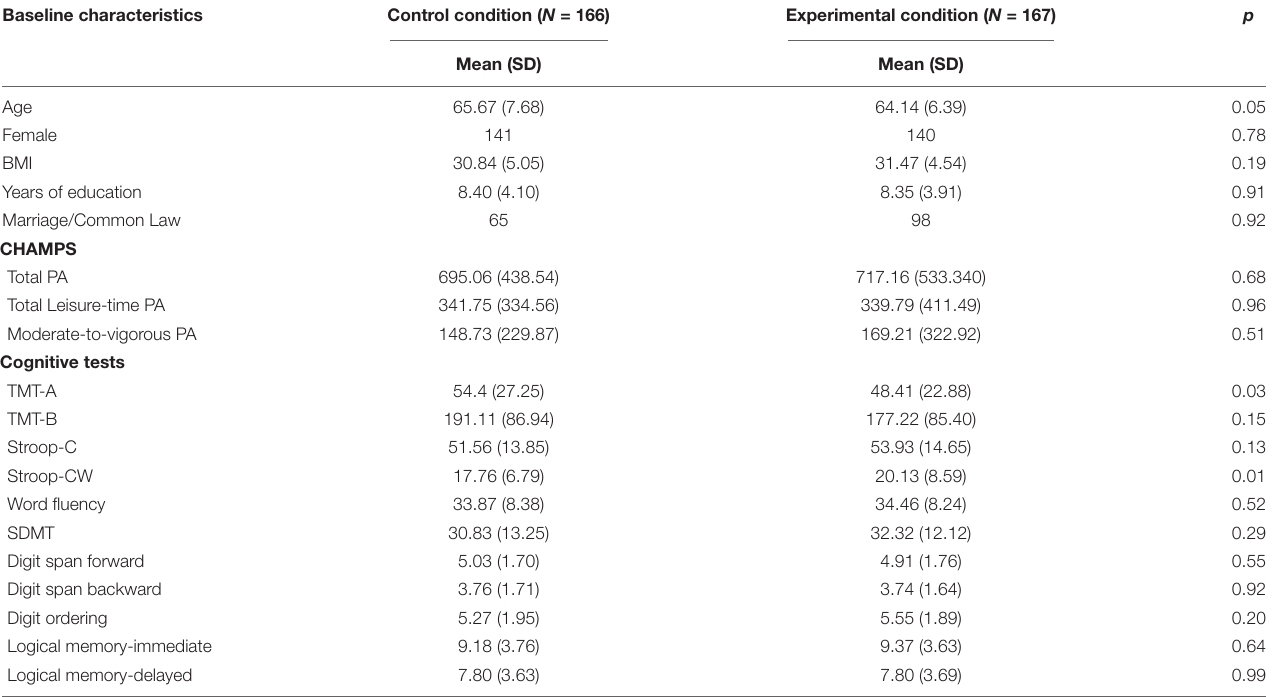
TABLE 1 | Demographic characteristics of the sample. Baseline characteristics